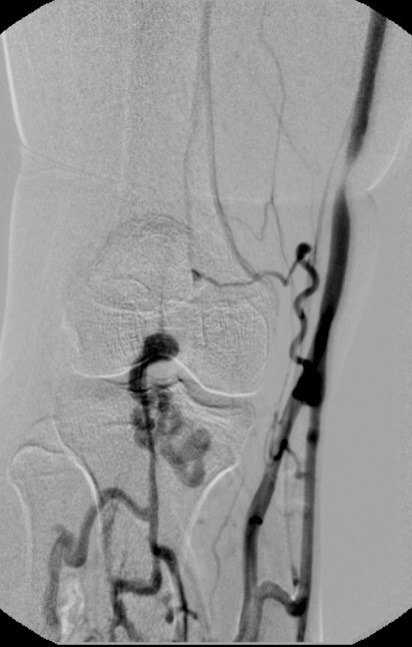
Ascending phlebography showing deep veins of the leg with anomalous drainage to the great saphenous vein. The popliteal vein was not visible.